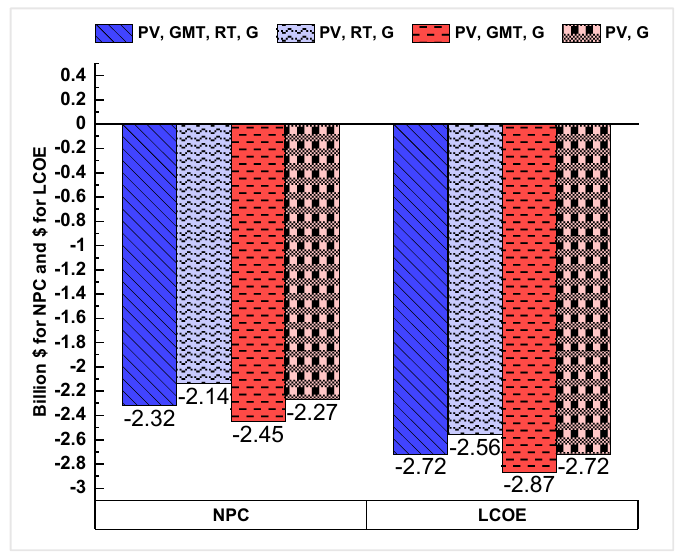
Figure 7. Cost comparison of PV/GMT/RT/G, PV/RT/G, PV/GMT/G, and PV/G configurations.